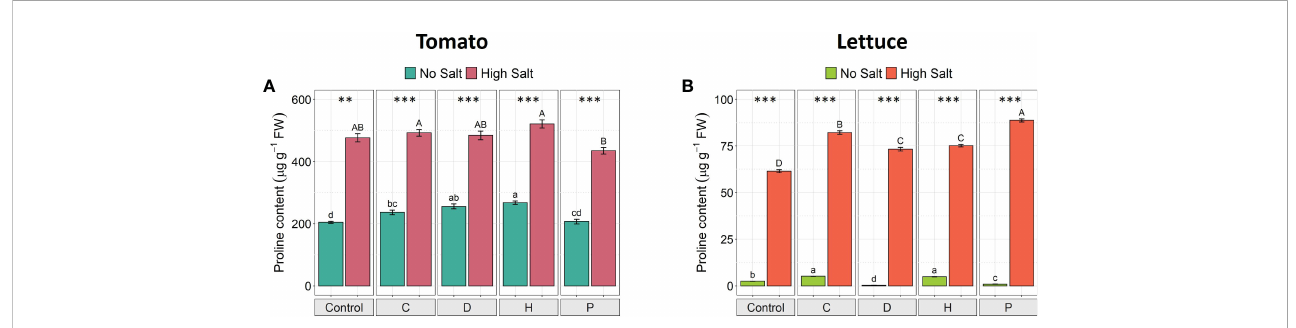
FIGURE 3 Effect of salinity and protein hydrolysates in the proline accumulation of tomato (A) and lettuce (B) plants. Values are means ± SE. Lowercase letters compare treatments under no salt, and capital letters compare treatments under high salt. Equal letters correspond to average values that do not differ according to Tukey ’ s HSD test (p < 0.05). Asterisks indicate signi fi cant differences between high and no salt, according to Student ’ s t- test (**p < 0.01, ***p <